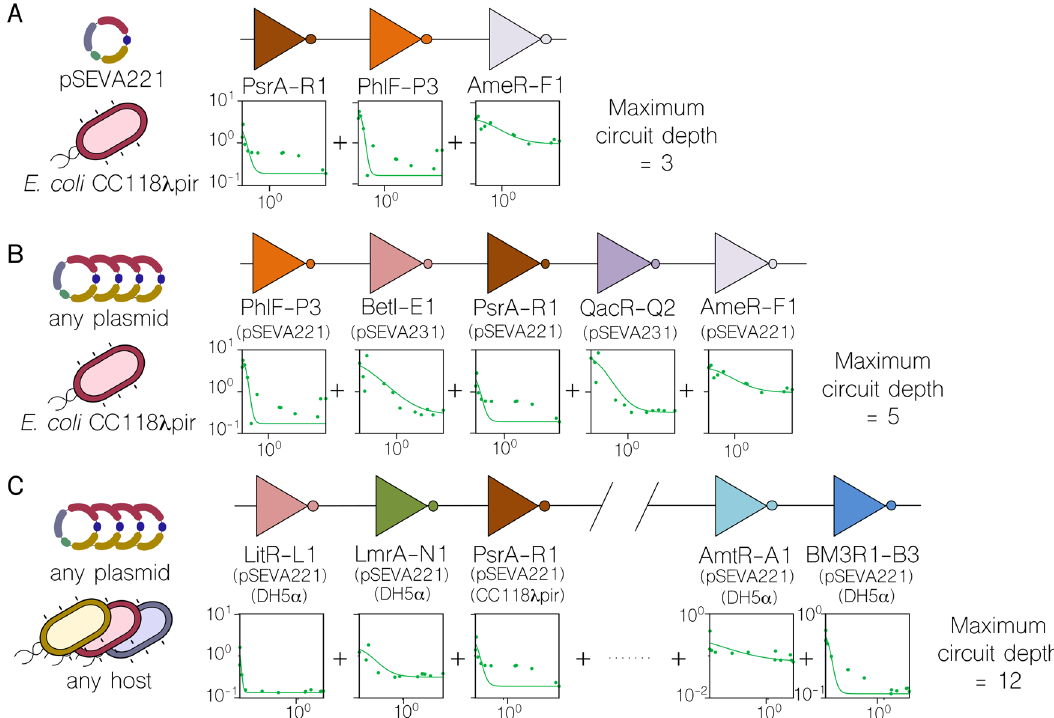
Fig. 4 Calculation of maximum circuit depth as a result of layering inverters. Based on the compatibility between gates, these were layered within the library in order to evaluate the impact of contextual dependencies on circuit size. For all graphs: x-axis refers to the input and y-axis to the output (both RPU). a The maximum depth calculated when the computational method is forced to consider all gates carried by the low copy-number plasmid pSEVA221 and hosted by Escherichia coli CC118 λ pir, is 3 gates-deep. b If the algorithm is free to select any plasmid (but still forced to E. coli CC118 λ pir), the maximum depth increases to 5. In this scenario, two gates are carried by the medium copy-number plasmid pSEVA231. c In the last analysis, the calculation used all contextual dependencies, including the variation in host chassis. The maximum number of gates layered increases to12 (only 5 shown in fi gure — refer to Supplementary Material for more information). In the sketch shown in the fi gure, 4 out of the 5 gates were characterised in the strain Escherichia coli DH5 α